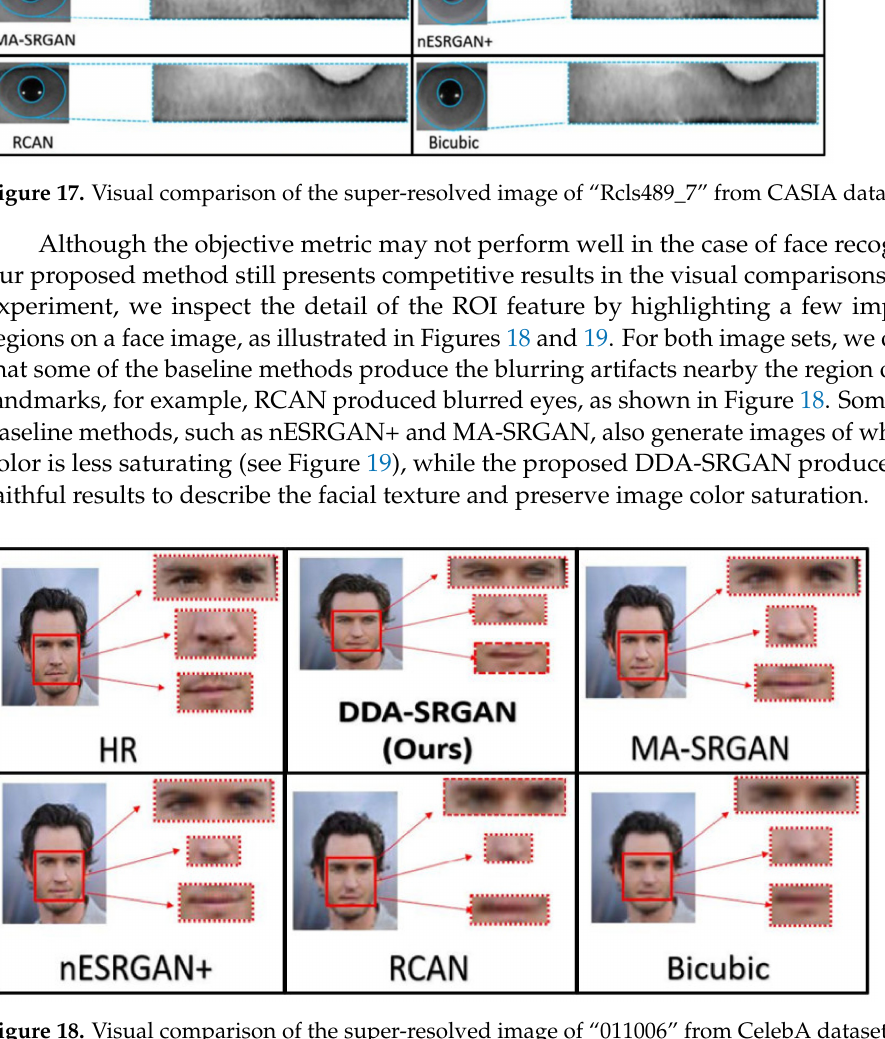
Figure 18. Visual comparison of the super-resolved image of “011006” from CelebA dataset.